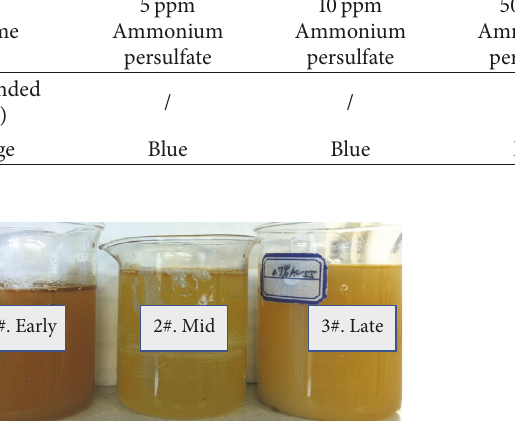
Figure 2: Flowback sample collected in different periods (Samples 1#–3#).